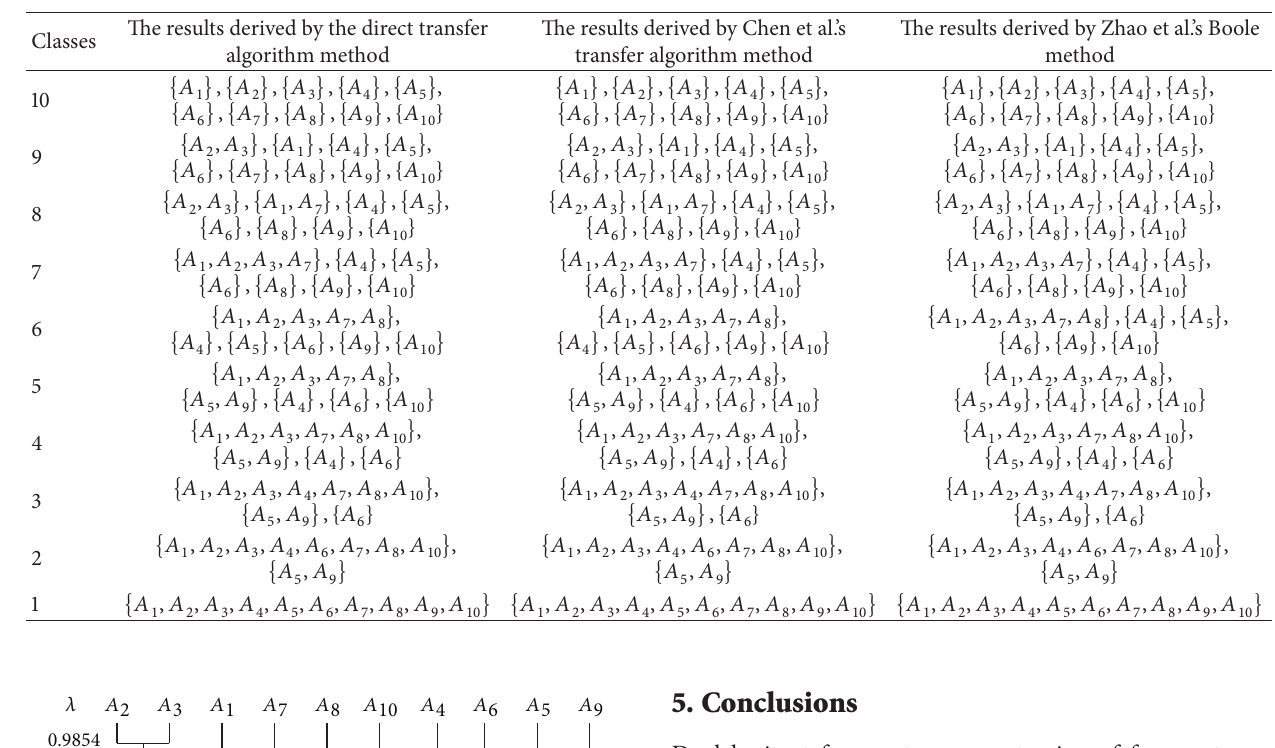
Table 8: Comparisons of the derived results.